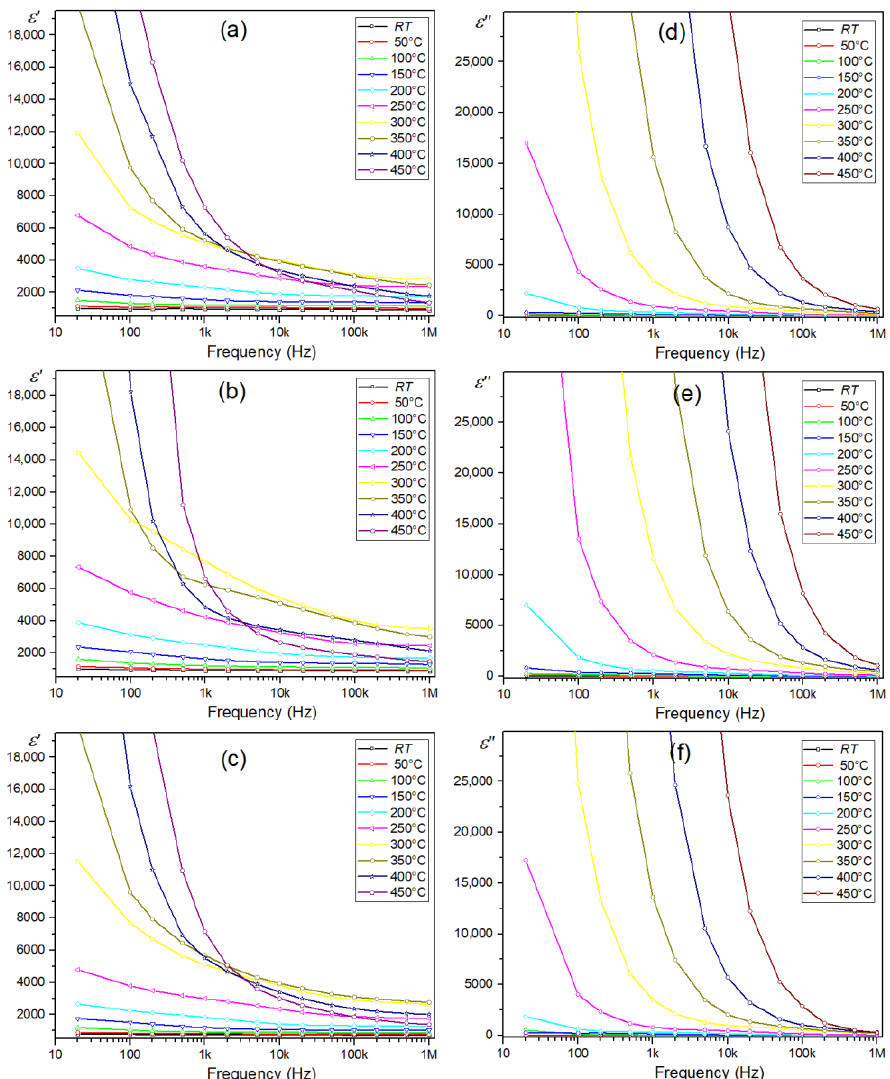
Figure 10. Frequency dependence of real part of permittivity ε ( a – c ) and dielectric loss ε ( d – f ) for the PF multiferroic composites: PF-SPS ( a , d ), PF-HP ( b , e ), and PF-FS ( c , f ).